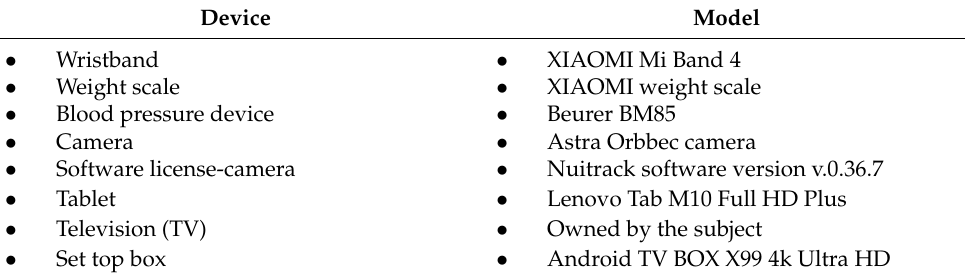
Table 3. List of the equipment used in HF and IHD use cases.